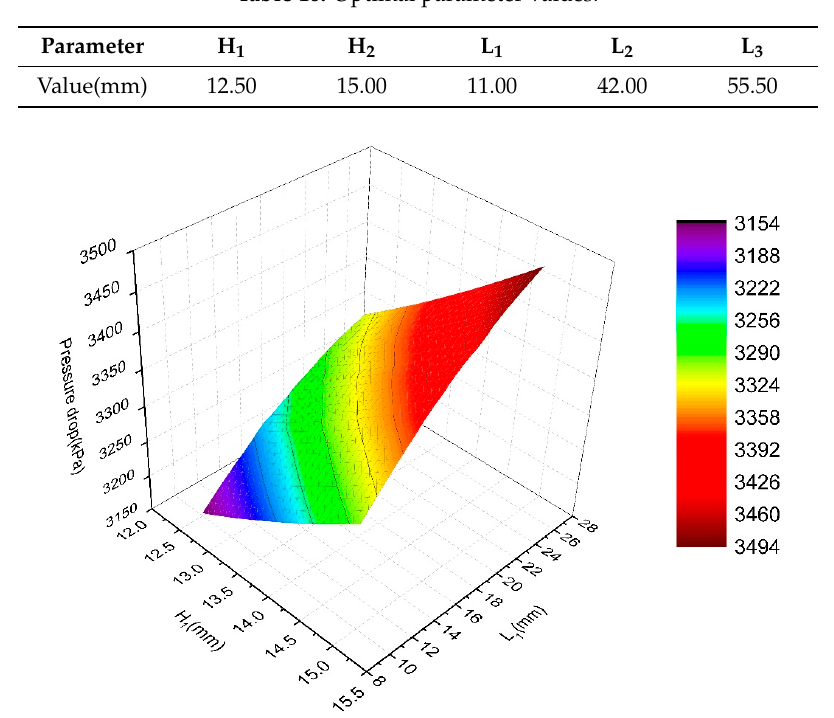
Figure 23. L 1 , H 1 and pressure drop surrogate model.